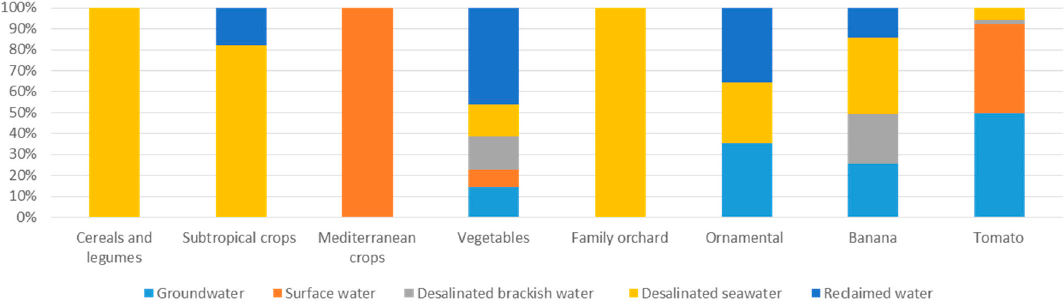
Figure 7. Typology of water resources used per crops in farms of the study area (% per hectare).